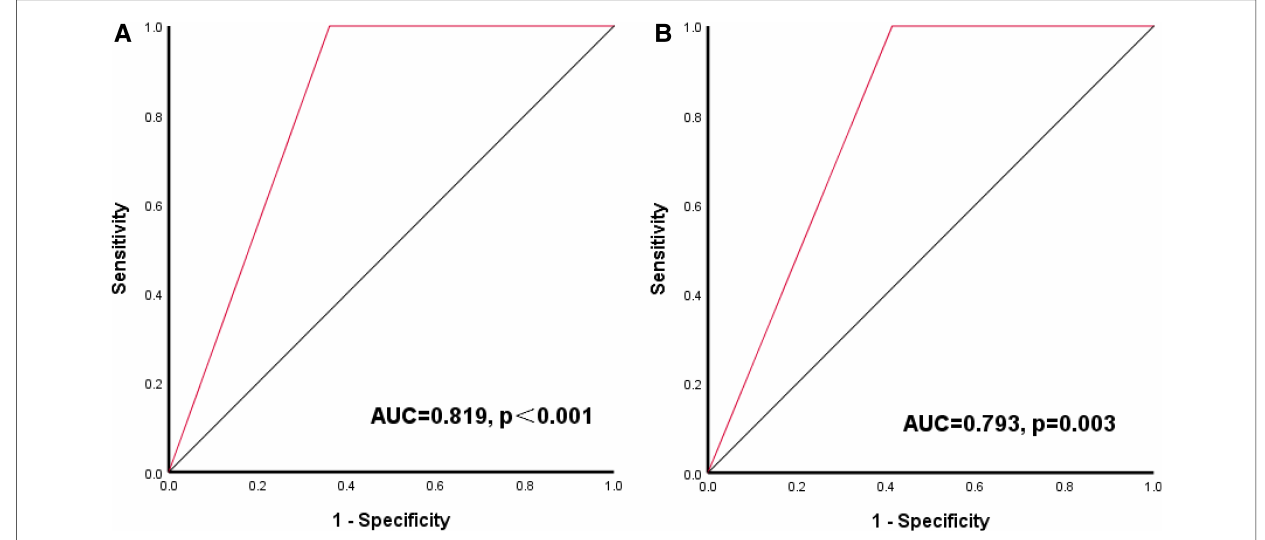
FIGURE 3 Receiver-operating characteristic (ROC) curve of LVMI combined with RWT for outcomes after LT ( A ) ROC curve of LVMI combined with RWT for SAE; ( B ) ROC curve of LVMI combined with RWT for